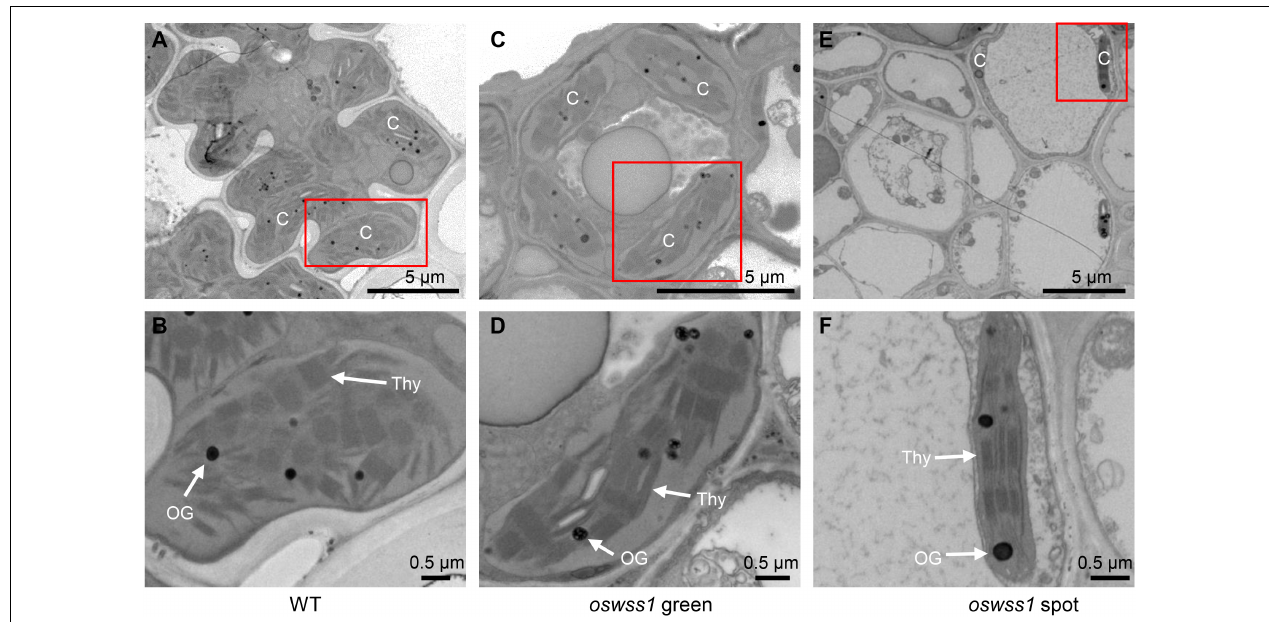
FIGURE 3 | Comparison of chloroplast ultrastructural between wild type (WT) and oswss1 leaves at the tillering stage (87 DAS). Transmission electron microscopy (TEM) was used to detect the chloroplasts ultrastructural in WT leaves (A,B) , oswss1 green sectors (C,D) and oswss1 spot sectors (E,F) . C, chloroplast; OG, osmiophilic plastoglobuli; Thy, thylakoid. The red box indicates the area